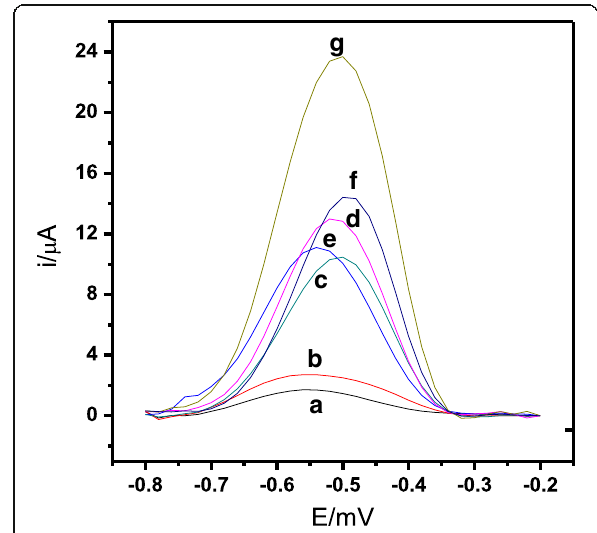
Fig. 3 Differential pulse voltammograms signal from AQMS of the electrodes ( a ) PSA-SPE, ( b ) PSA-AuNPs-SPE, ( c ) capture probe-PSA- AuNPs-SPE and when in the presence of ( d ) ncDNA and reporter probe, ( e ) mismatch DNA and reporter probe, ( f ) cDNA alone, and